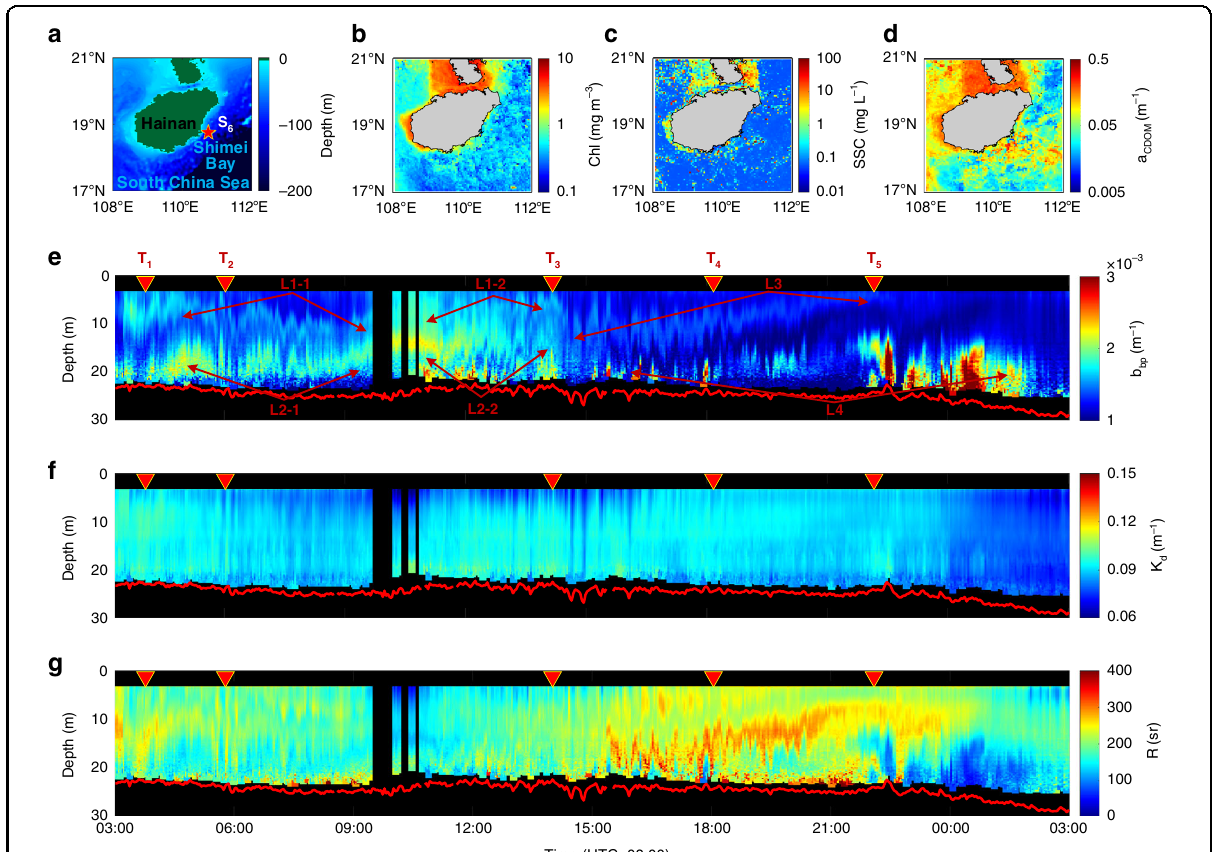
Fig. 4 A diel continuous measurement for a fi xed station. Plots of a water depth from ETOPO1, b Chl, c SSC, d a CDOM from HY-1C (Methods) with the ship track in red lines. Pro fi les of e b bp , f K d , g R retrieved by HSRL with 3 optical depths in red lines. Discrete in situ data were collected at different time T 1 -T 5